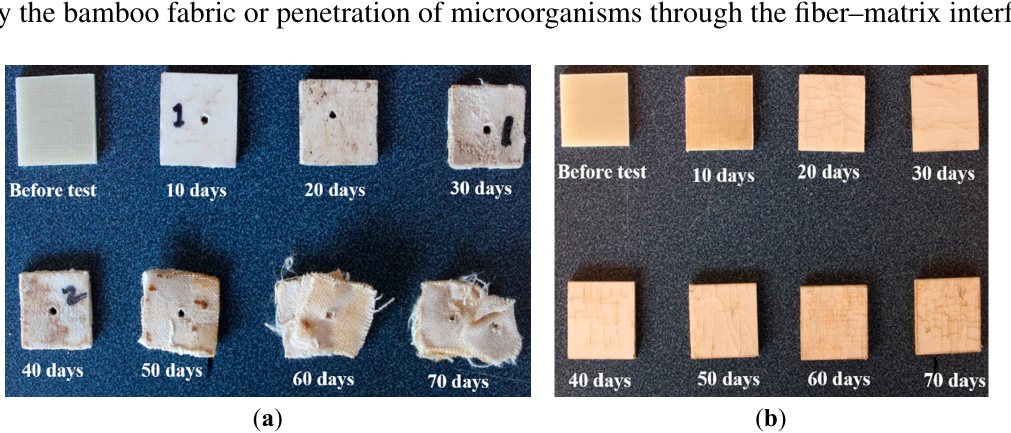
Figure 10. Biodegradation of bamboo fabric-reinforced PLA composites in controlled composting conditions ( a ) and real composting conditions ( b ).